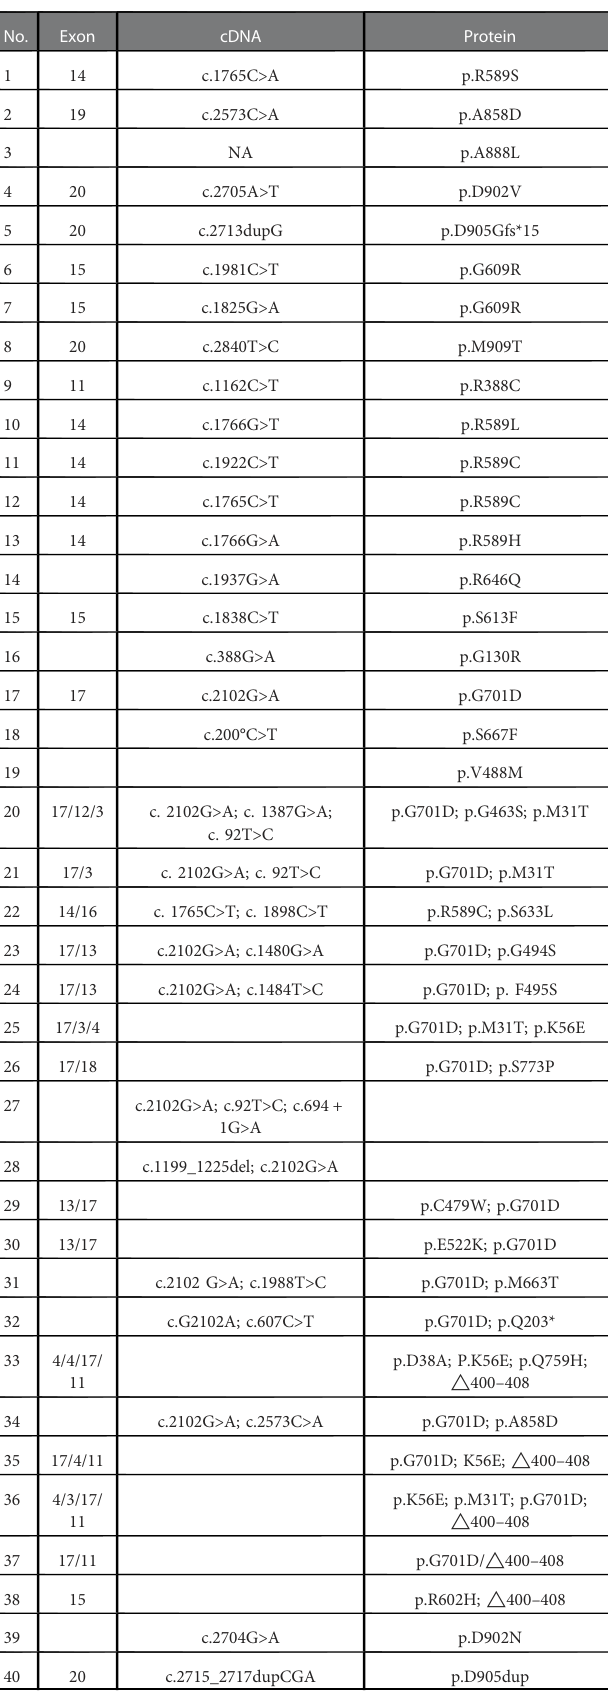
TABLE 1 Mutations in SLC4A1